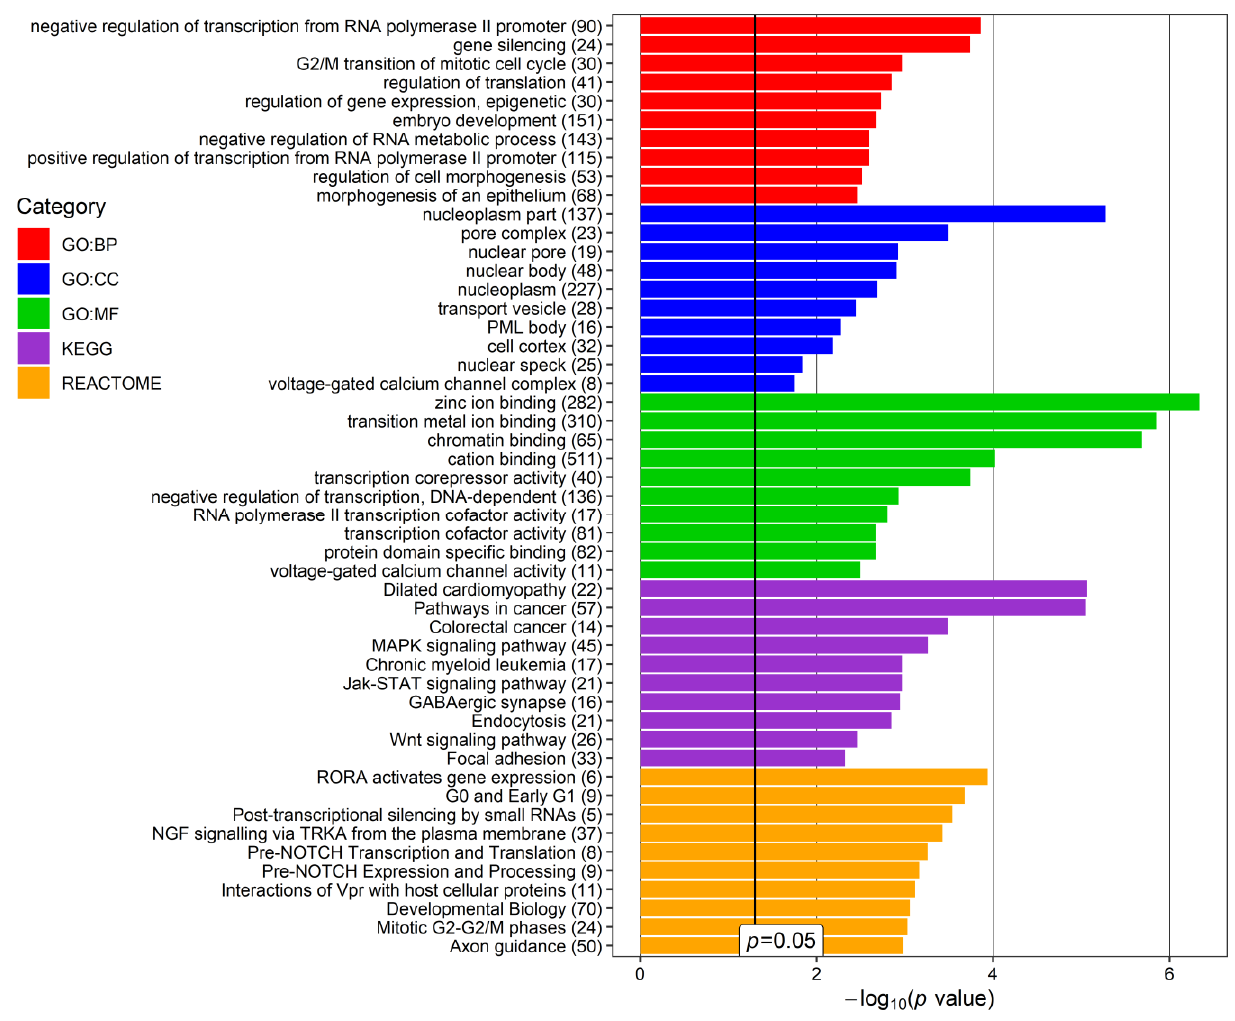
Figure 6. Top 10 terms of the Gene Ontology (GO): Biological Processing (GO:BP), GO: Cellular Compartment (GO:CC), Molecular Function (GO:MF), REACTOME, and KEGG (Kyoto Encyclopedia of Genes and Genomes) categories, revealed for glaucoma- and/or pseudoexfoliation syndrome (PEX)-associated genes targeted by upregulated miRNAs found in the current study in the aqueous humor (AH) of patients with PEXG and age-matched controls. P -value—EASE score for enrichment adjusted by the Benjamini correction for multiple-hypothesis testing. The number in brackets following the names of terms indicates the number of associated genes. The plot was generated using the ggplot2 3.3.0 package in an R environment.